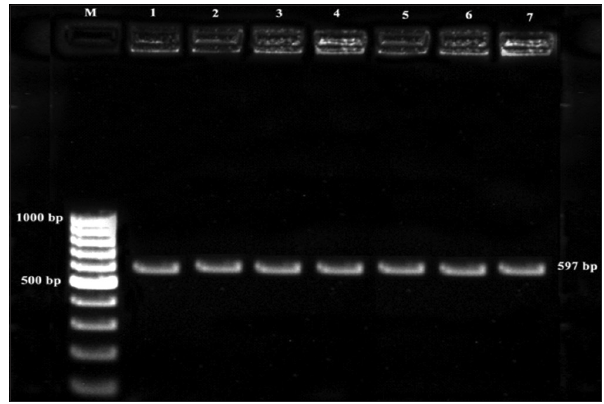
Figure-4: Multiplex PCR profile for serotyping of L. monocytogenes isolates. Lane M: 100 bp ladder, Lane1: Dry fish, Lane 2: Prawn, Lane 3: Mussels-1, Lane 4: Mussels-2, Lane 5: Fish Lane 6: Prawn 2, Lane 7: 1143.